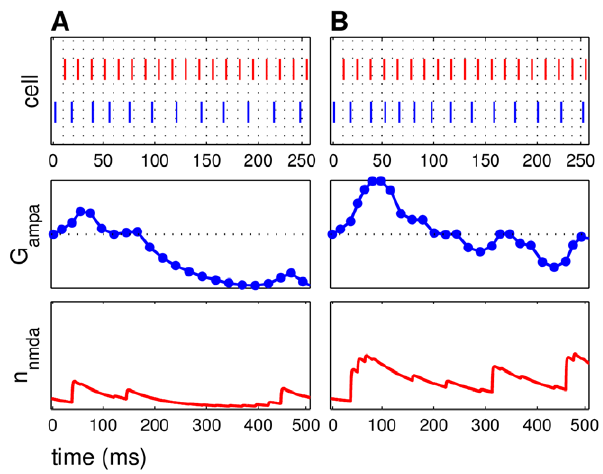
Figure 6. A longer NMDAR current decay results in larger average potentiation. The top panel in each subfigure shows a raster plot with input spikes (red) and E cell spikes (blue), enlarged over the first 250 ms to show detail. Second panels are AMPAR conductance over time. Bottom panels are NMDAR current open probabilities n nmda . (A) The initial NMDAR current decay t nmda was 80 ms. This frequency regime ( f N =41 Hz, f I =77 Hz) potentiated. Here, AMPAR and NMDAR events did not occur at regular intervals. (B) t nmda was increased to 130 ms. The same mean ISI and I app , e were used, corresponding to the same frequency regime as seen in (A). However, this frequency regime shows a greater amplitude of potentiation, seen in the rise in AMPAR